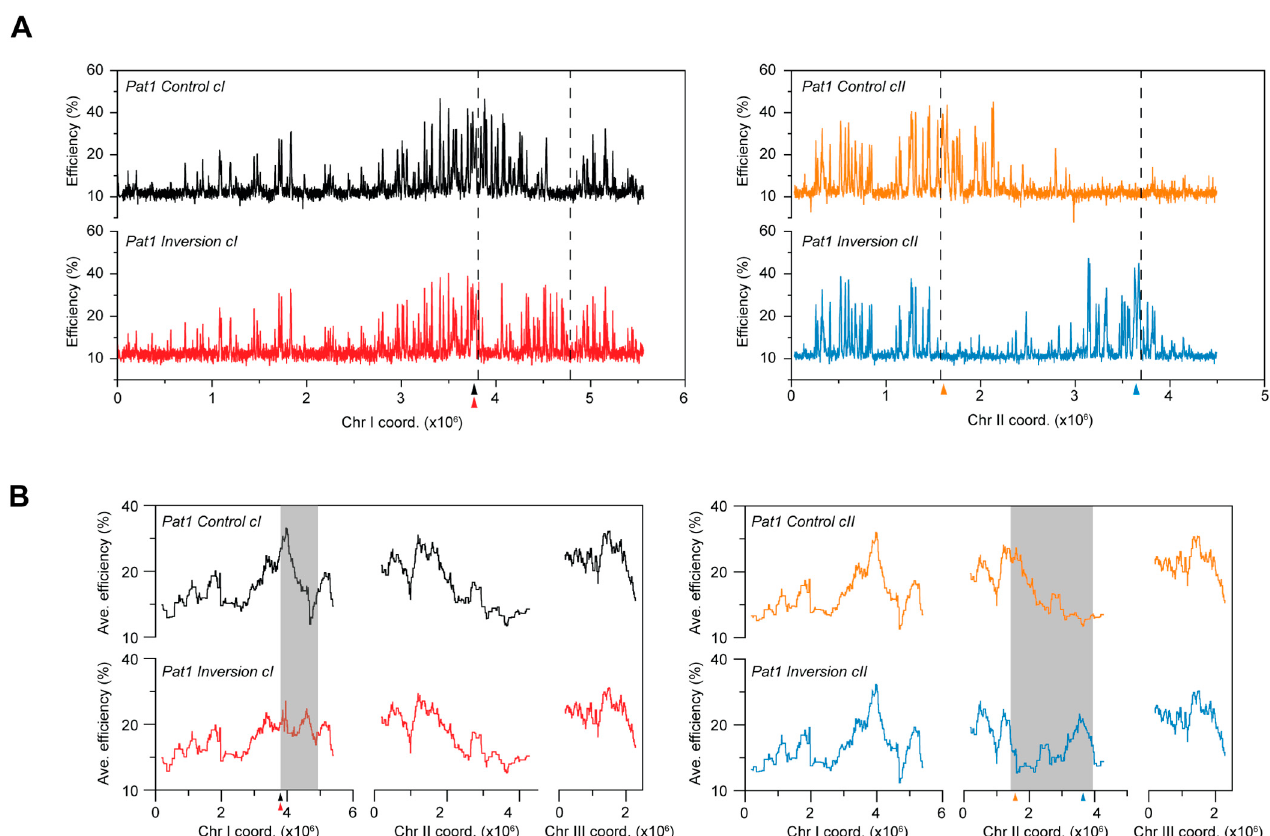
Figure 5. The impact of chromosomal inversions on the replication program of pre-meiotic S phase. ( A ) Replication profiles of the chromosomal inversion strains during pre-meiotic S phase plotted using the actual post-rearrangement chromosomal coordinates. Only the rearranged chromosomes are shown. Black: Pat1 Control cI , red: Pat1 Inversion cI , orange: Pat1 Control cII , blue: Pat1 Inversion cII . x -axis: chromosome coordinates, y -axis: origin efficiencies. ( B ) Profiles of replication domains. Averages of origin efficiencies were determined for continuous windows of ~250 kb (1000 probes) across the entire genome. x -axis: chromosome coordinates, y -axis: average origin efficiencies. Gray boxes highlight changes in origin efficiency domains along the chromosomes that result from chromosomal inversions. Triangles with colors corresponding with each of the strains indicate the positions of centromeres.